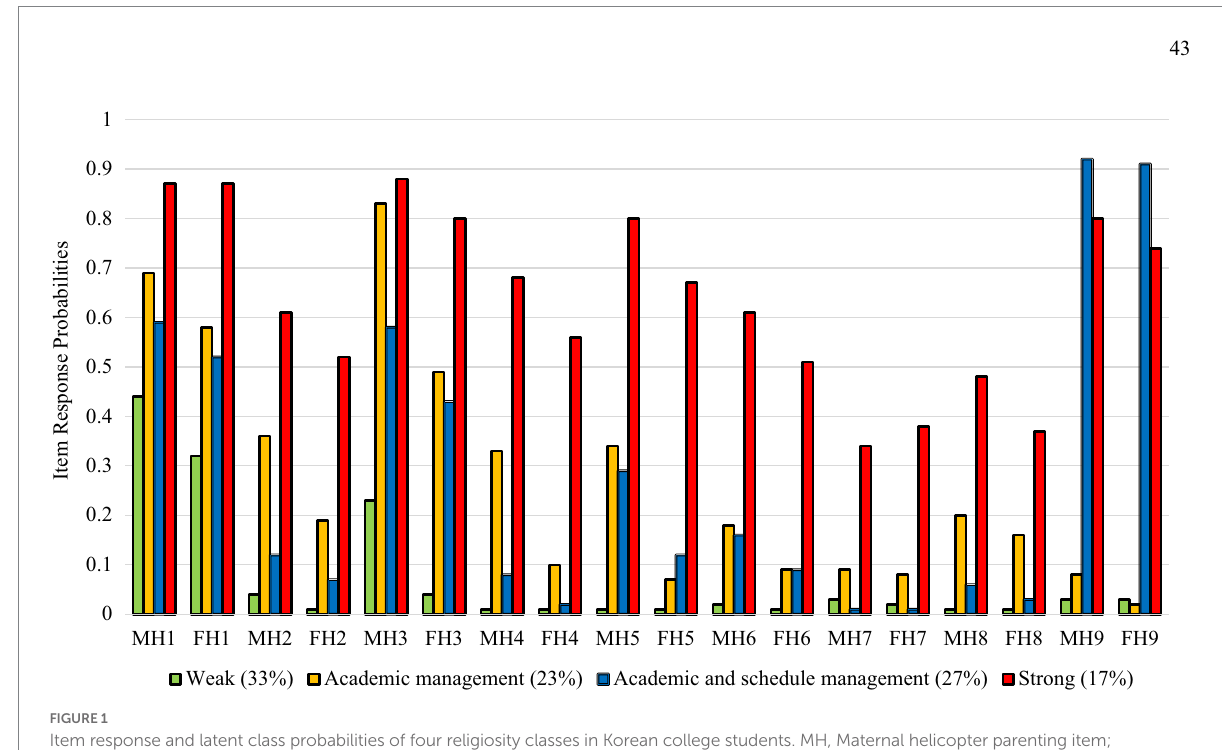
Bolded values indicate best fit for each respective statistic. BIC, Bayesian Information Criterion; CAIC, Consistent Akaike Information Criterion; VLMR, Vuong-Lo–Mendell–Rubin Test.